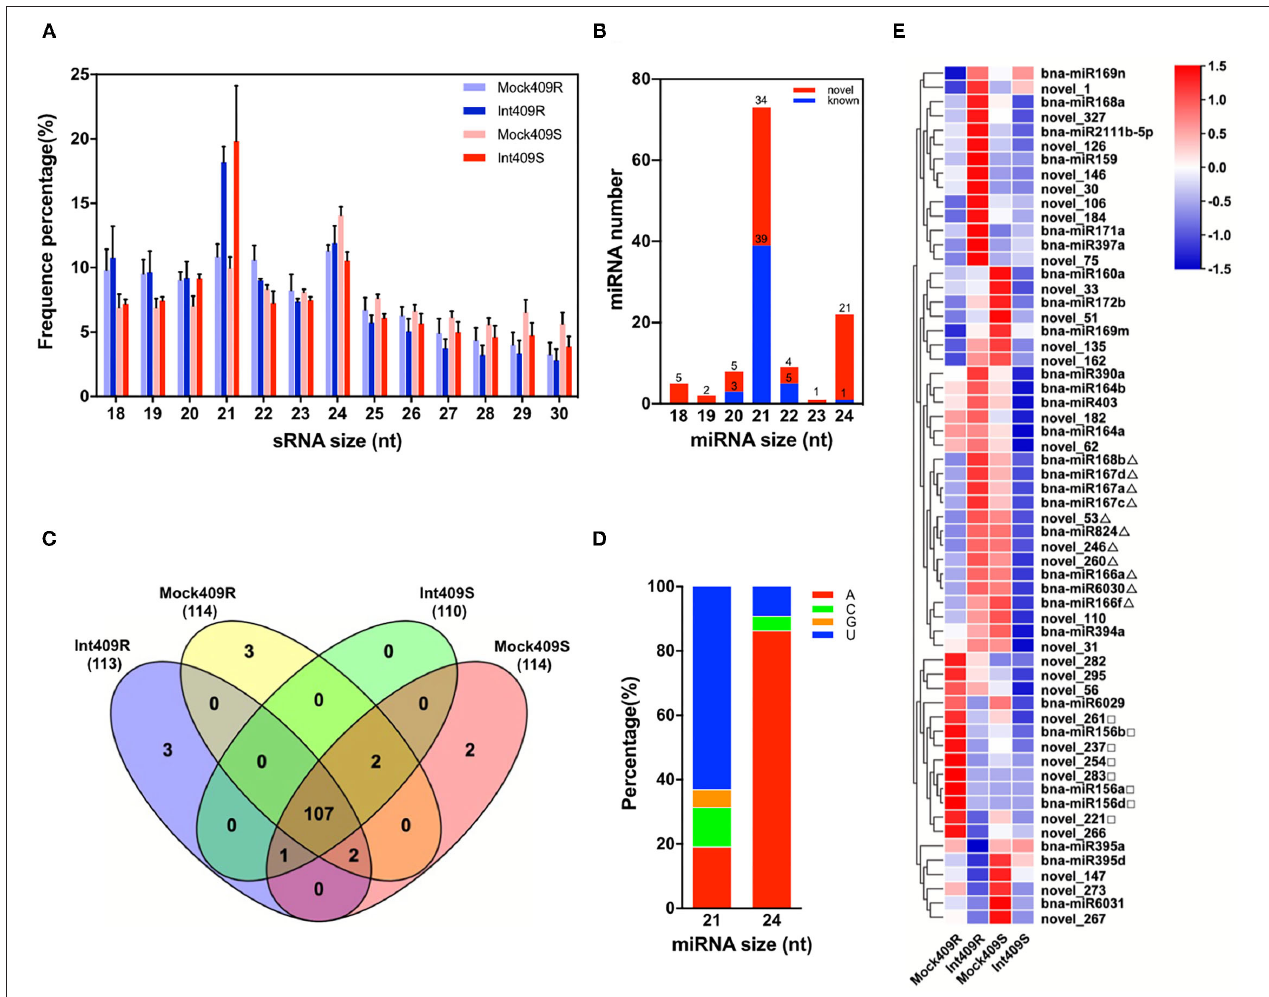
FIGURE 1 | Identification and characterization of micro ribonucleic acids (miRNAs) in resistant and susceptible Brassica napus upon Plasmodiophora brassicae infection. Distribution of (A) Small RNA (sRNA) length in 12 sRNA libraries and (B) length distribution of miRNAs, (C) Venn diagram of the number of miRNAs in 409R and 409S with or without P. brassicae infection, (D) preference of the first nucleotide for 21 or 24-nt miRNAs, and (E) heat map of 60 highly expressed miRNAs. 1 and (cid:3) mark some miRNAs with different expression patterns between 409R and 409S in response to P. brassicae